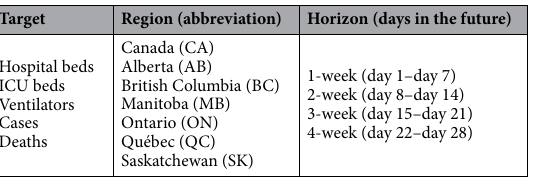
Table 1. The 5 targets, 7 regions, and 4 horizons of our forecasting models.